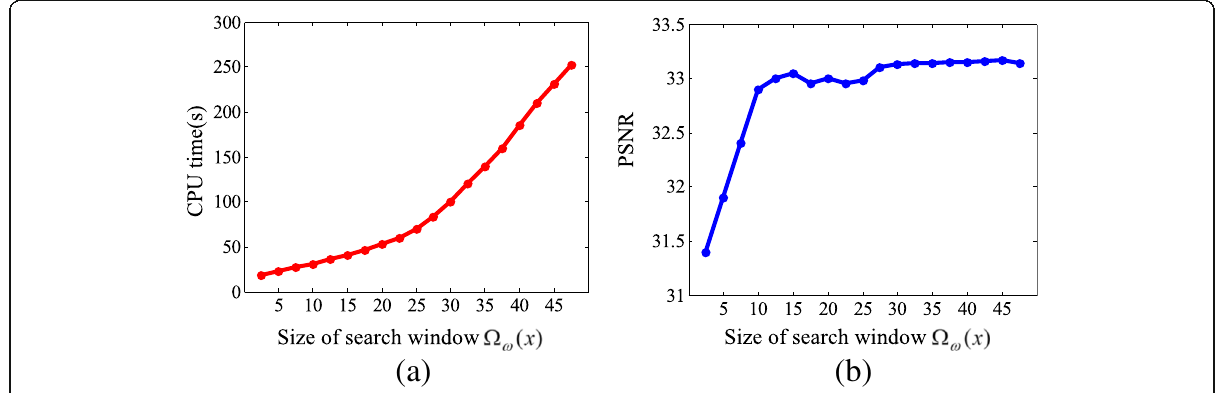
Fig. 4 Analysis for search window Ω ω ( x ) of the nonlocal TV operator. a Curve of CPU time to window size. b Curve of PSNR to window